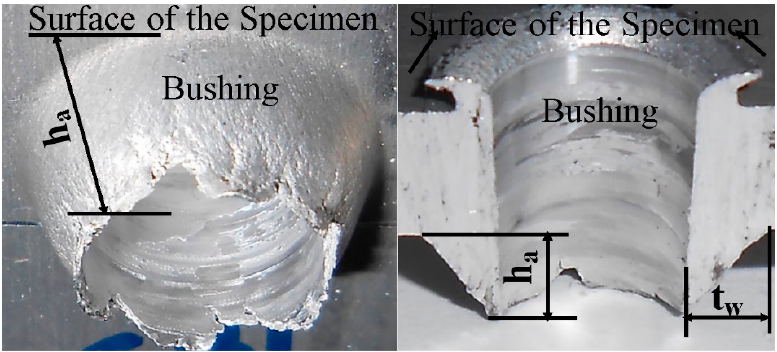
Figure 3. Bushing height on the bushing shape.